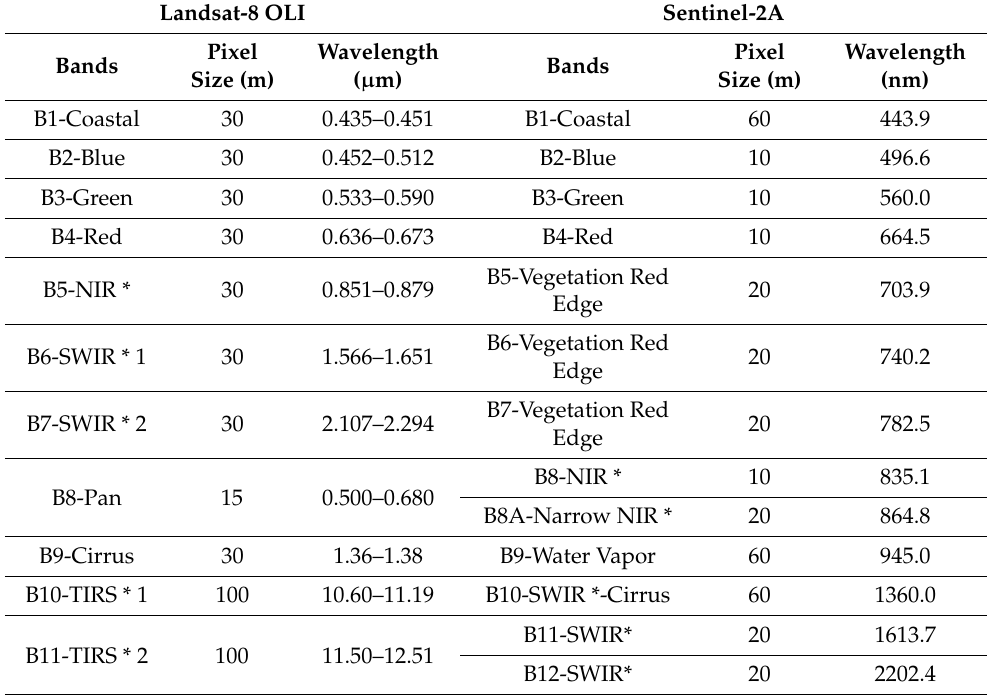
Table 1. Corresponding Landsat-8 and Sentinel-2 bands and